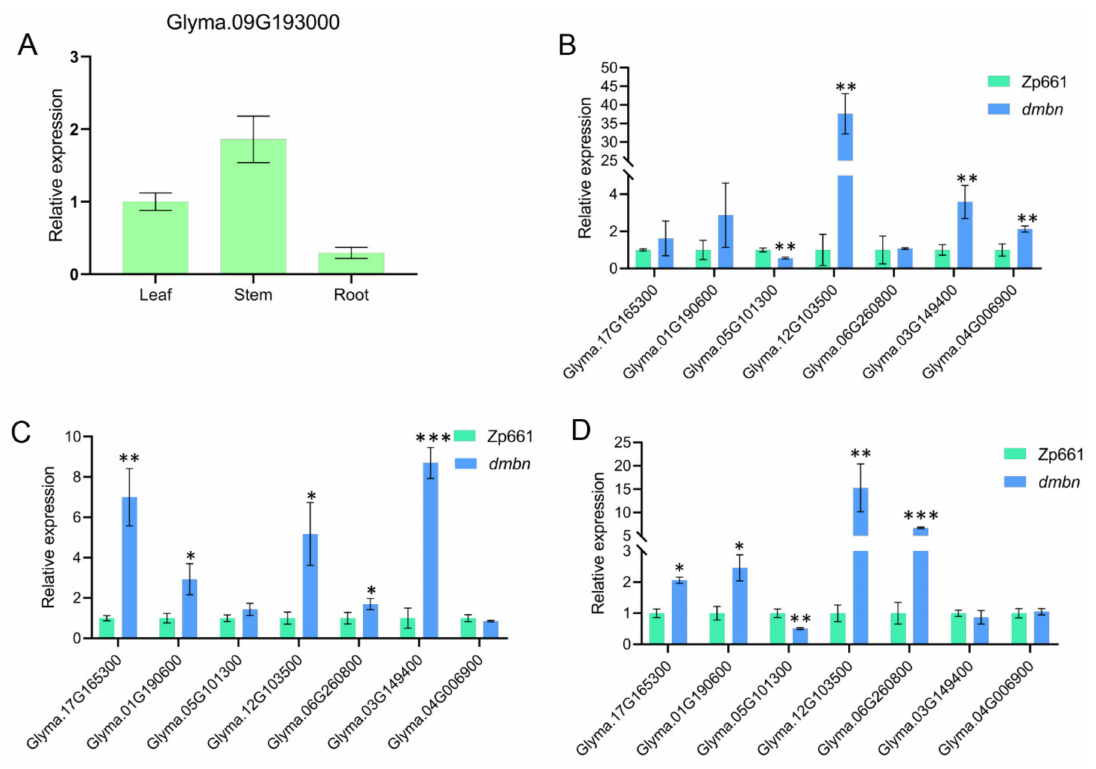
Figure 7. Relative expression analysis of GmIAA27 and auxin-responsive genes. ( A ) qRT-PCR relative expression of GmIAA27 in root, stem, and leaf. ( B – D ) qRT-PCR analysis of relative expression of GH3s in leaf ( B ), stem ( C ), and root ( D ) in Zp661 and dmbn . Values are means ( ± s.e.m.) ( n = 3 plants each with three technical repeats), Student’s t -test was used for comparisons (* p ≤ 0.05, ** p ≤ 0.01, *** p ≤ 0.001).